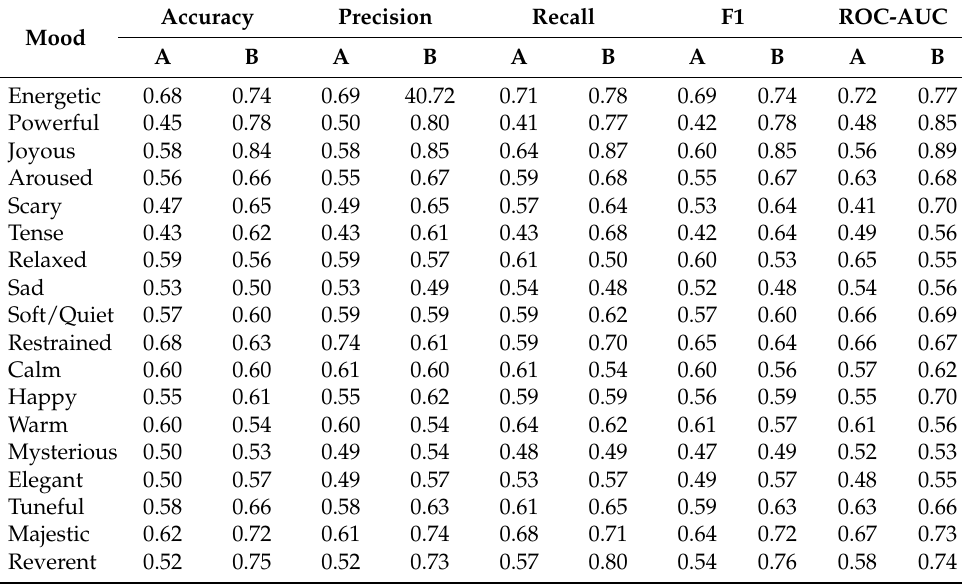
Table 2. Dataset A, Dataset B Model Experiment